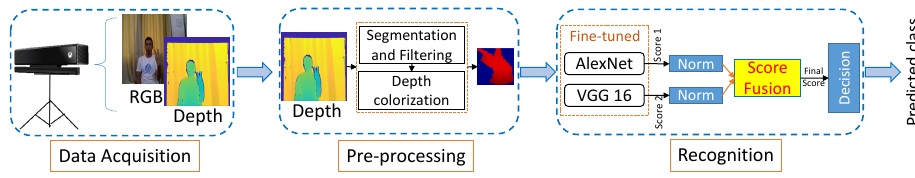
Figure 1. The proposed framework for the recognition of static hand gesture images.